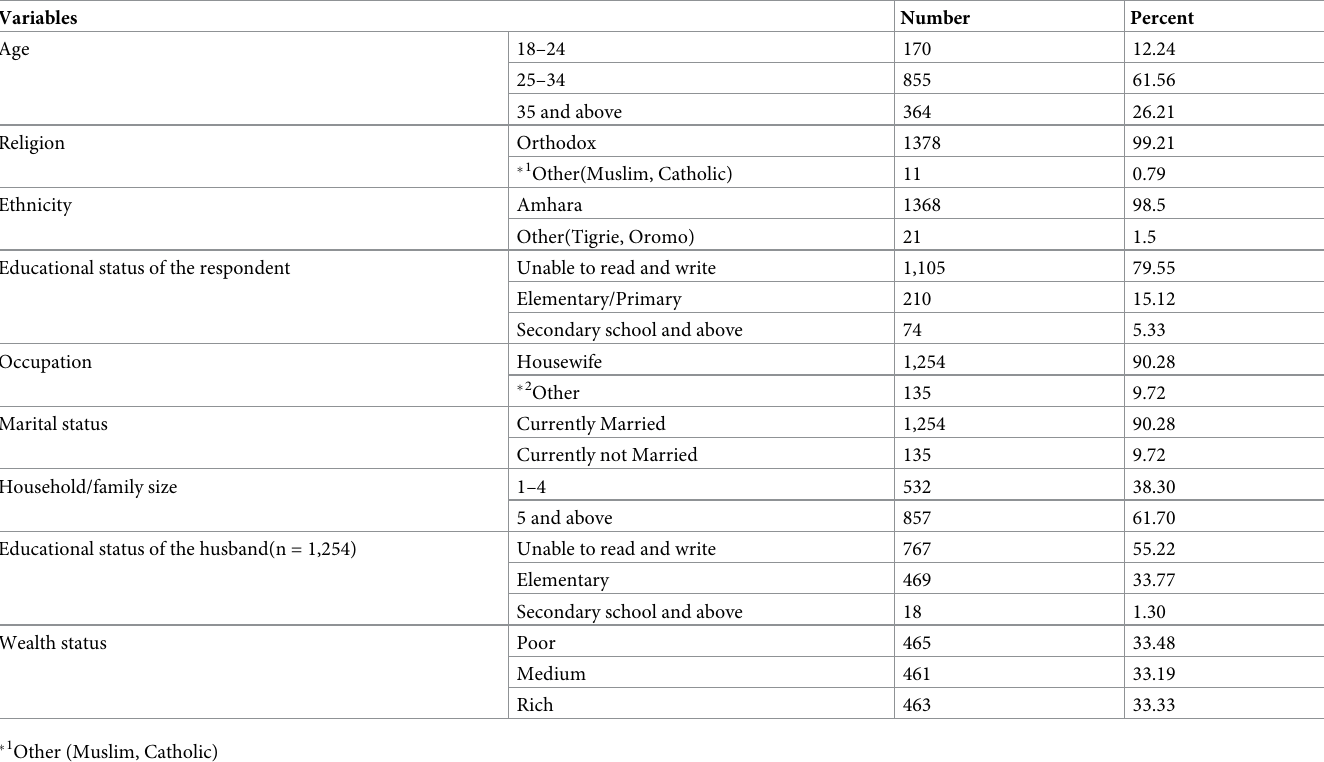
Table 1. Socio-economic and demographic characteristics of women in Wogera and East Dembiya District, North West Ethiopia, 2020. Variables